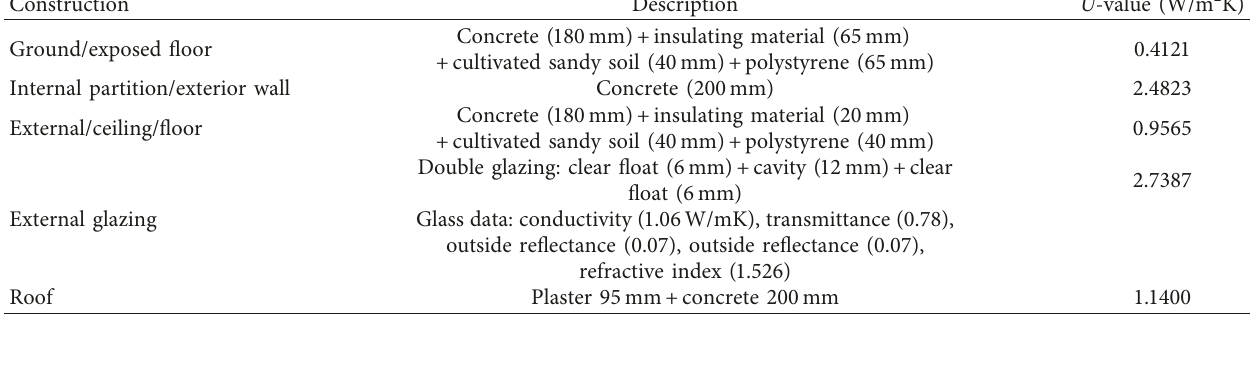
Table 1: Material properties and conditions of the computer model.